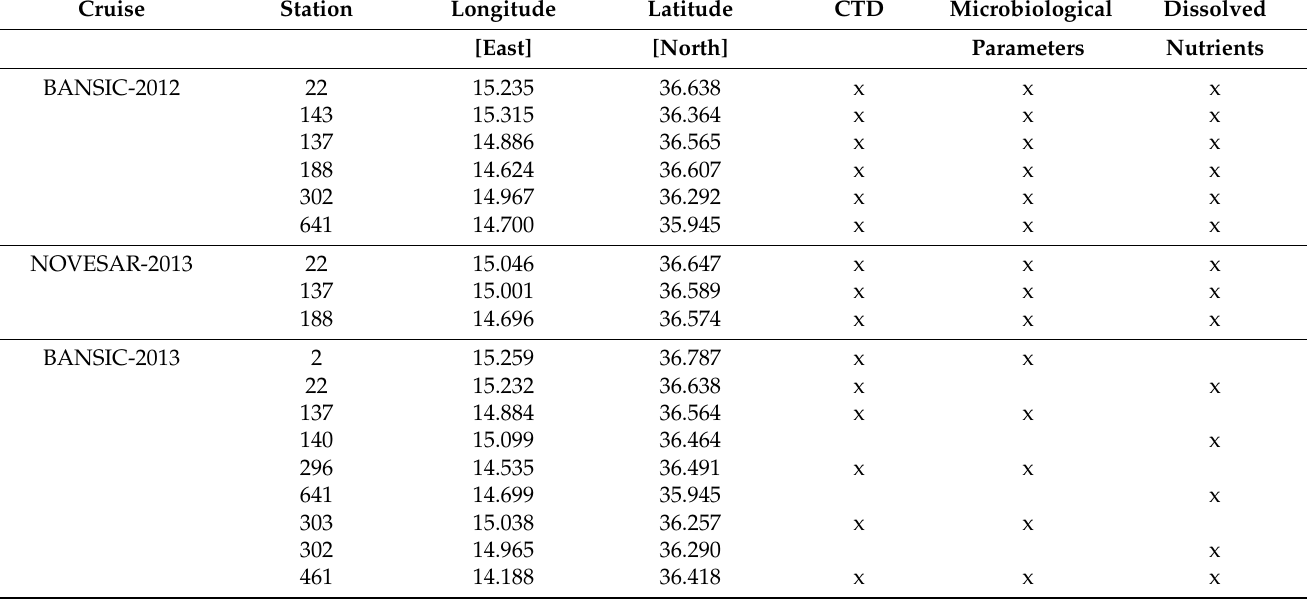
Table 1. Sampling stations, coordinates, names of cruise and measurements taken